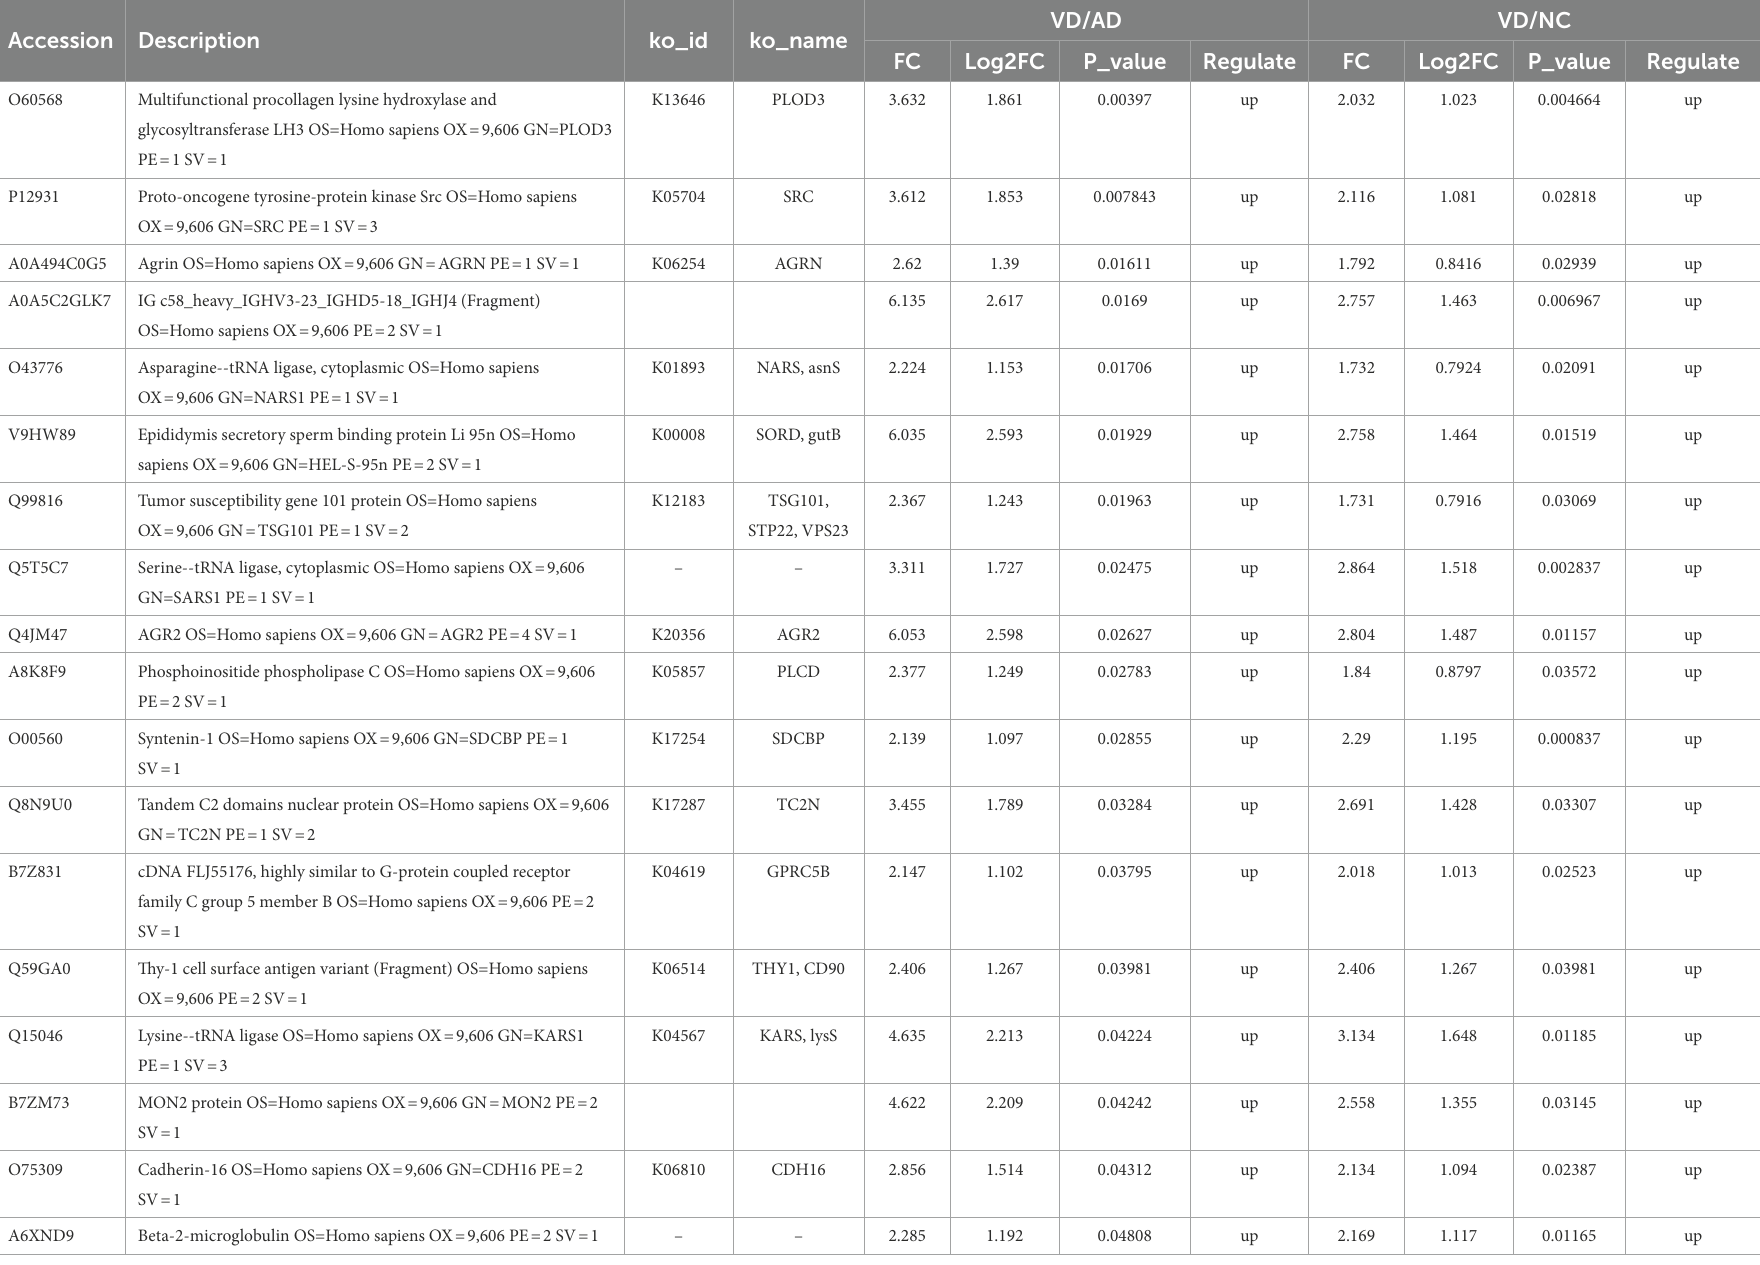
TABLE 2 Urine differentially expressed proteins between VD, AD, and NC patients.